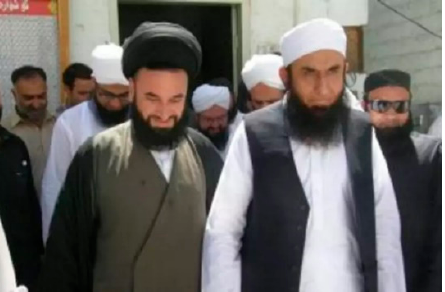
Figure 9. Maulana Tariq Jamil building bridges with the Shia. Source: https://www.parhlo.com/life- of-molana-tariq-jameel/.